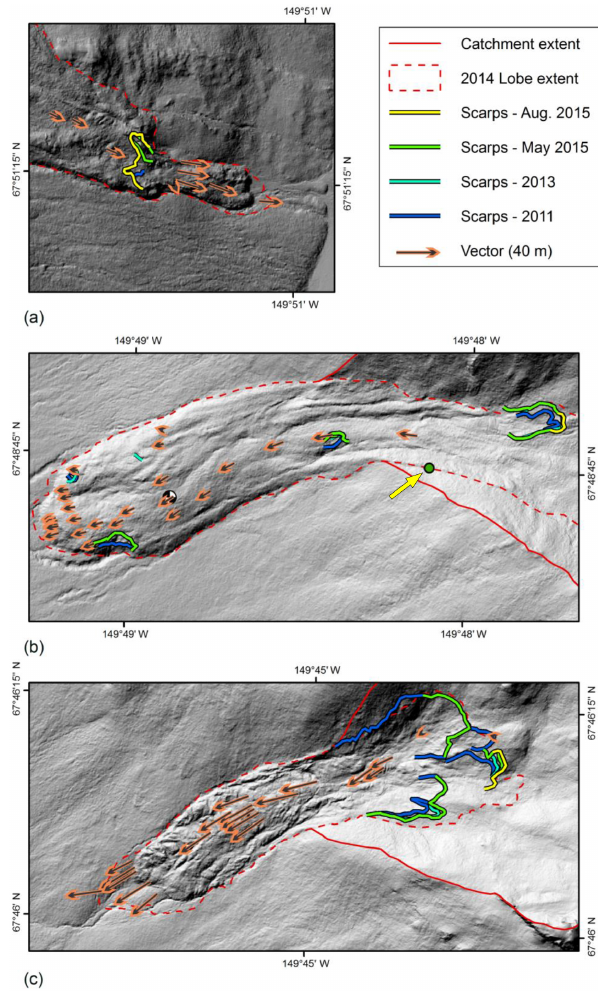
Figure 5. Vector maps of (a) FDL-7, (b) FDL-A, and (c) FDL–D, summarizing movement measured from June 2013 to August 2015, and RTS development. The scale of each image is 1:10000. Vectors are scaled from the 40m scale included in the legend. The arrow and the green dot in (b) indicate the location of sampled organics for radiocarbon dating, and the location of the 2012 borehole on FDL- A is indicated by the white and black symbol. As the base maps are from 2011 lidar data (Hubbard et al., 2011), the 2014 FDL extents are also